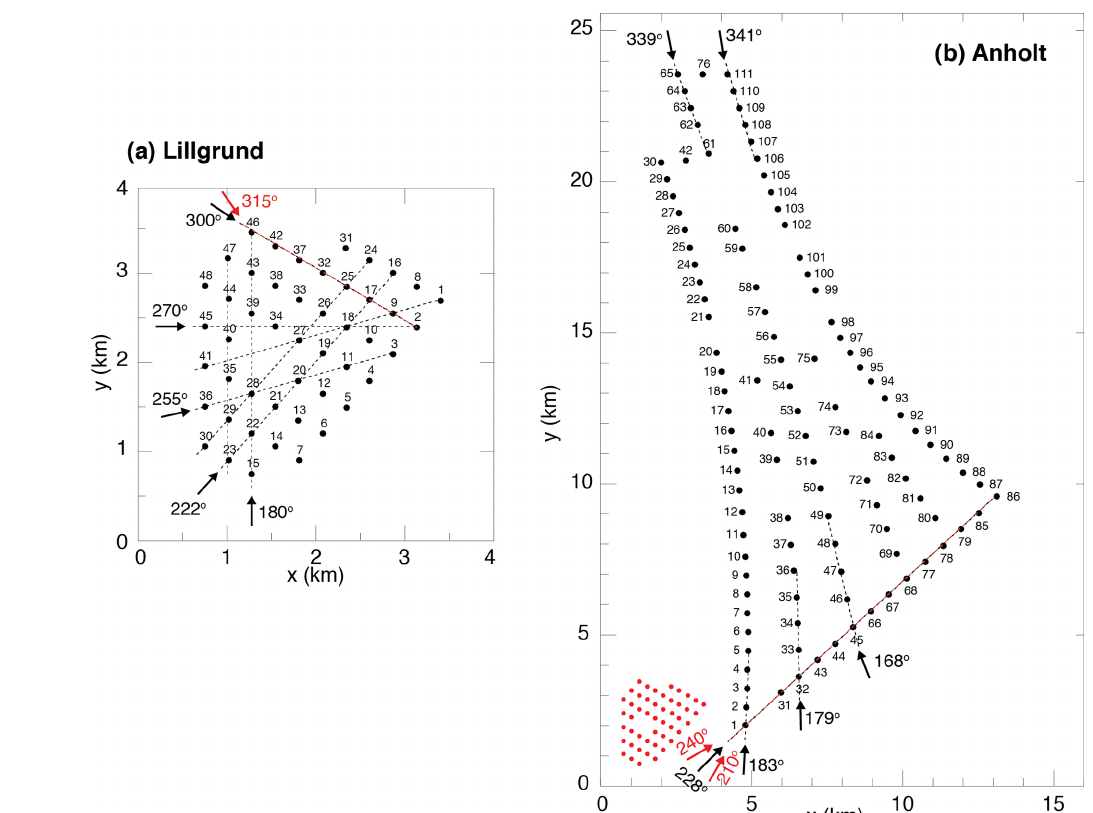
Figure 3. Wind turbine layout at Lillgrund (a) and Anholt (b) . The Lillgrund wind farm is also plotted in panel (b) with red dots using the same scale as that for the Anholt wind farm. The dashed black lines indicate the wind directions (black arrows) aligned with wind turbine columns. The red arrows indicate the directions of non-alignment. The dashed red lines are the columns analyzed in this study for the non-alignment